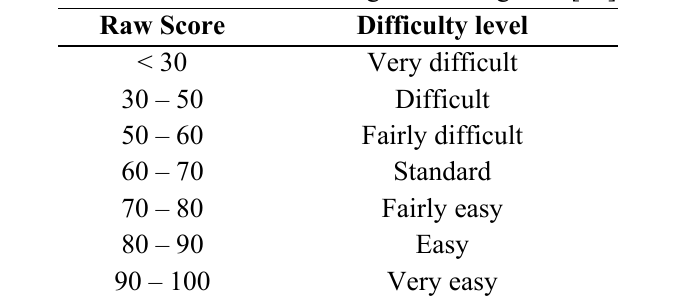
Table 2. Flesch Reading Ease Categories [10]